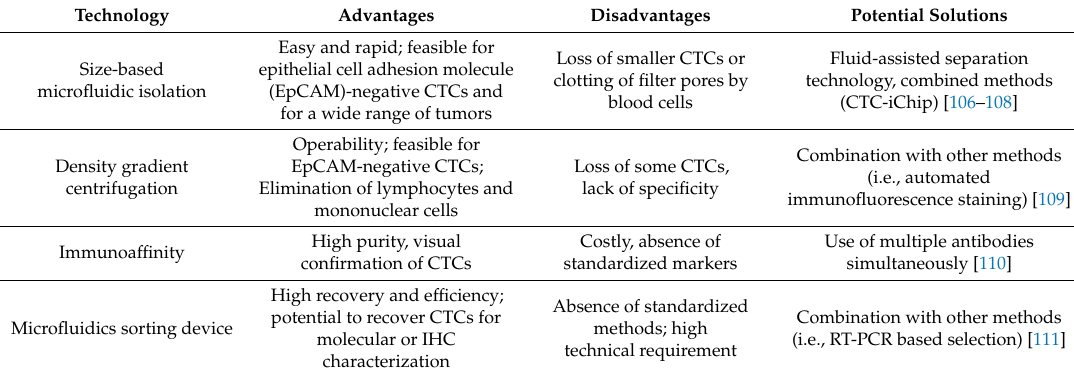
Table 3. Currently available CTC methods of enrichment and